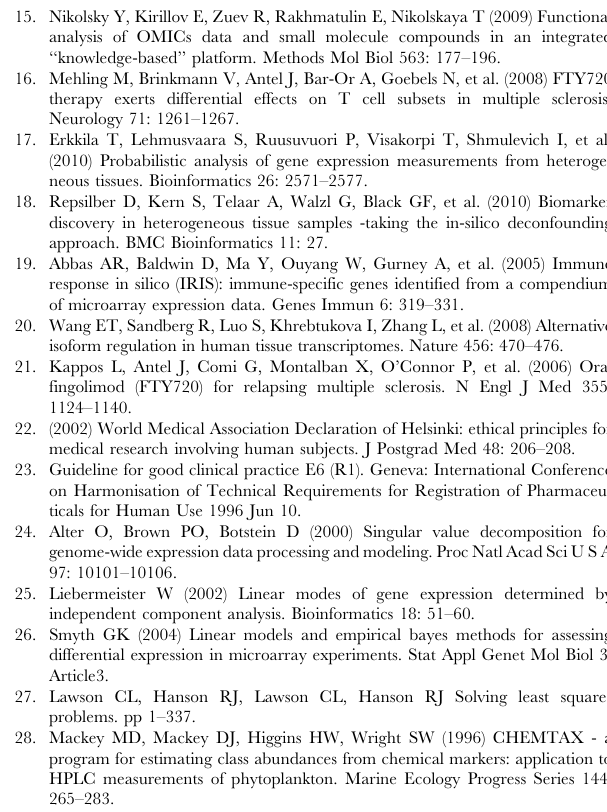
Figure S4 Stability of chosen signature matrix. (a) Boxplot displaying the stability of chosen signature matrix. The chosen signatures are distorted by randomly selecting 5, 10, or 15 percent of its genes and randomly modulating their values with 5 fold changes. The distribution of correlations between actual mixing fractions and fractions estimated using these signatures is depicted. (b) Condition number of the basis matrix with respect to the percentage of simulated differentially expressed genes in the basis matrix.